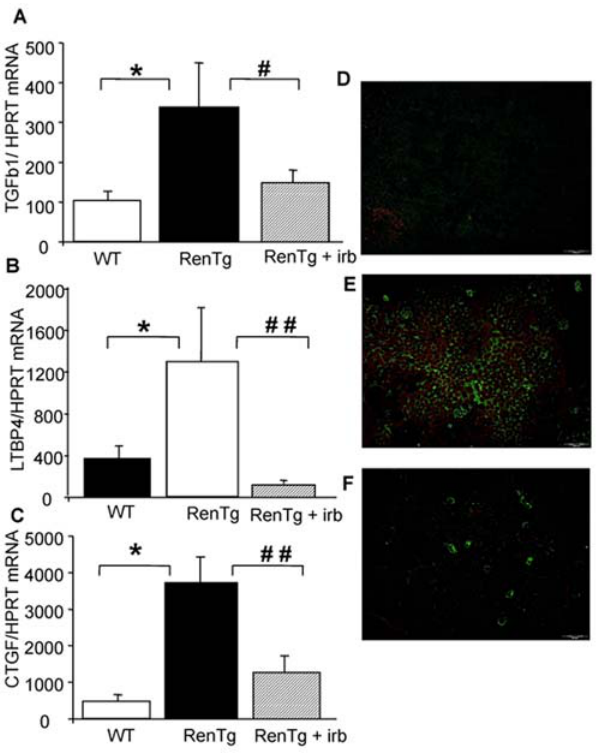
Figure 8. Expression of pro-fibrotic genes of the TGF b family is substantially decreased following AT1 receptor antagonism. Quantitative RT-PCR analysis of the expression of the pro-fibrotic genes TGF b (A), CTGF (B) and LTBP4 (C) in the renal cortex of wild type and RenTg mice before and after irbesartan treatment, and TGF b immunostaining in wild type (D) and RenTg mice before (E) and after (G) irbesartan treatment. Note that the increased expression of pro- fibrotic genes in RenTg mice was decreased to normal levels following treatment with the AT1 receptor antagonist. Values are mean 6 SEM; n=5, 9 and 13 for wild type and RenTg mice before and after irbesartan, respectively; * P , 0,05 vs WT; # P , 0,05 or ## P , 0,001 vs RenTg. Bar=200 m m.